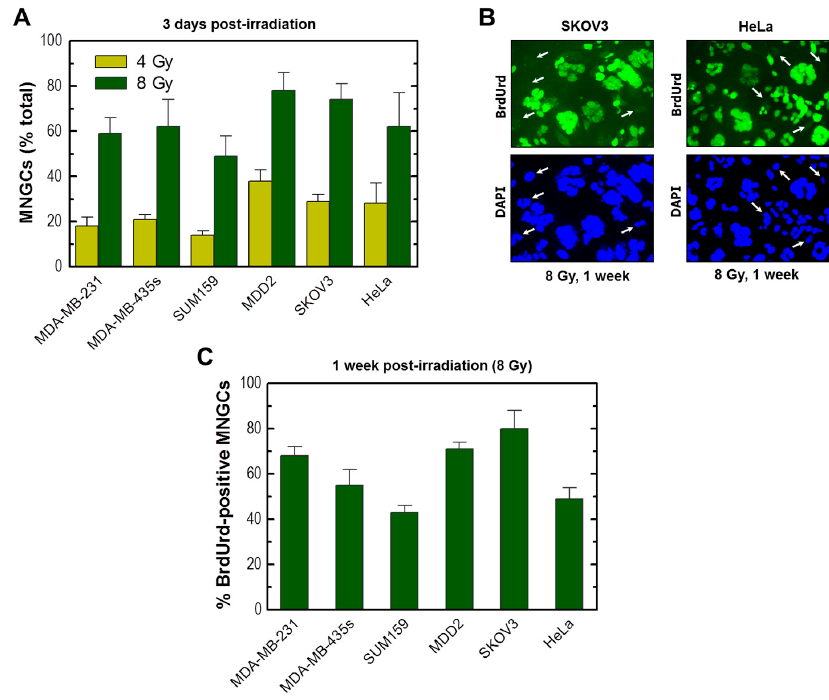
Figure 9. ( A ) Development of MNGCs in the indicated cancer cell lines 72 h after exposure to ionizing radiation. Bars, SE; ( B ) BrdUrd immunostaining of the indicated cultures that were exposed to radiation (8 Gy) and incubated for six days in fresh medium and for a further 24 h in medium containing BrdUrd. Images were acquired for regions in the dish that contained aggregates of cells (mini-colonies). Arrows show some cells that did not incorporate BrdUrd under these conditions; ( C ) Percentages of BrdUrd-positive MNGCs post-irradiation in the indicated cell lines. Bars, SE.